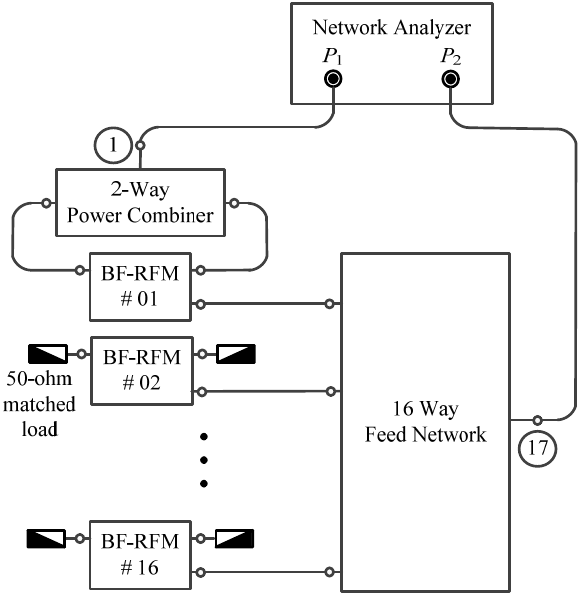
Figure 9. Measurement setup with the assigned ports 1~17 for the antenna system gains. They were measured by including the 16 BF-RFMs, the 16-way feed network, and 16 coaxial cables connecting each module and the feed network. In Figure 9, the